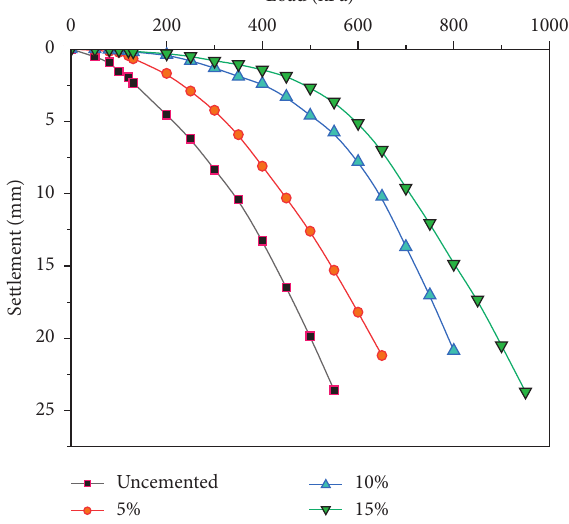
Figure 10: Bearing capacity of calcareous sand with different cement content.